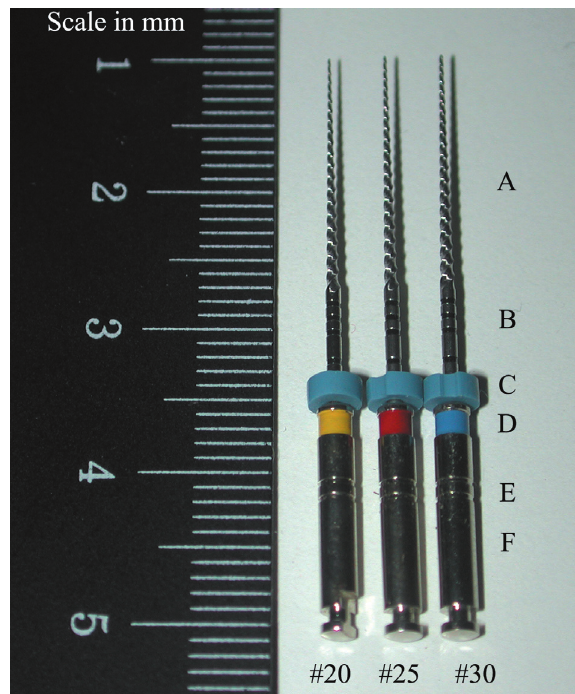
Figure 1- Macroscopic view of the endodontic files (FlexMaster) used in this study. They appear similar to the naked eye. A: The cutting portion. B: Depth marking facilitates determination of the exact position of the file on x-ray. C: Silicon rubber for working length marking. Color coding indicated according to ISO requirements (Yellow: Nº 20, Red: Nº 25, Blue: Nº 30.). E: The number of engraved rings on the shaft determines the taper of the instrument. One ring represents taper .02, 2 rings for .04 and 3 rings for taper .06. F: Specially designed shaft to be fitted in the handle of the low torque motor. The scale on the left is in